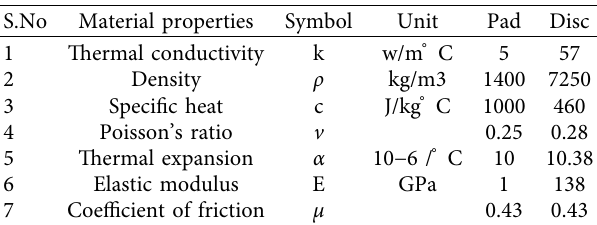
Table 1: Mechanical and thermophysical properties of disc brake and pad